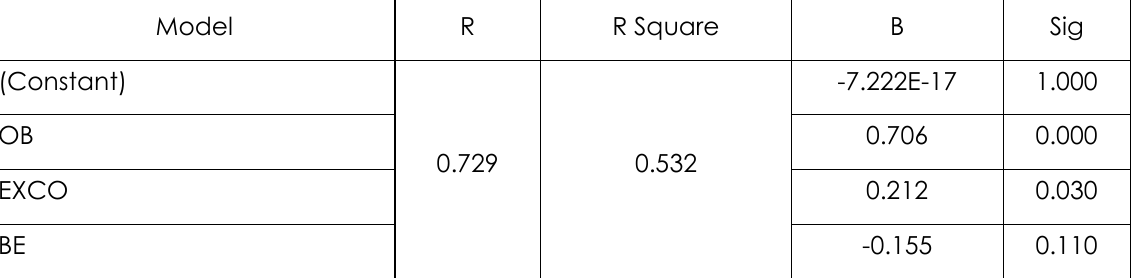
Table 3. SPSS Result of Multiple Regression of Compensation, Benefit, and Organisation Brand